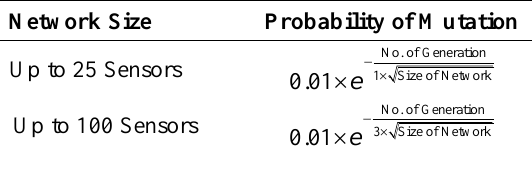
Table 4. Mutation